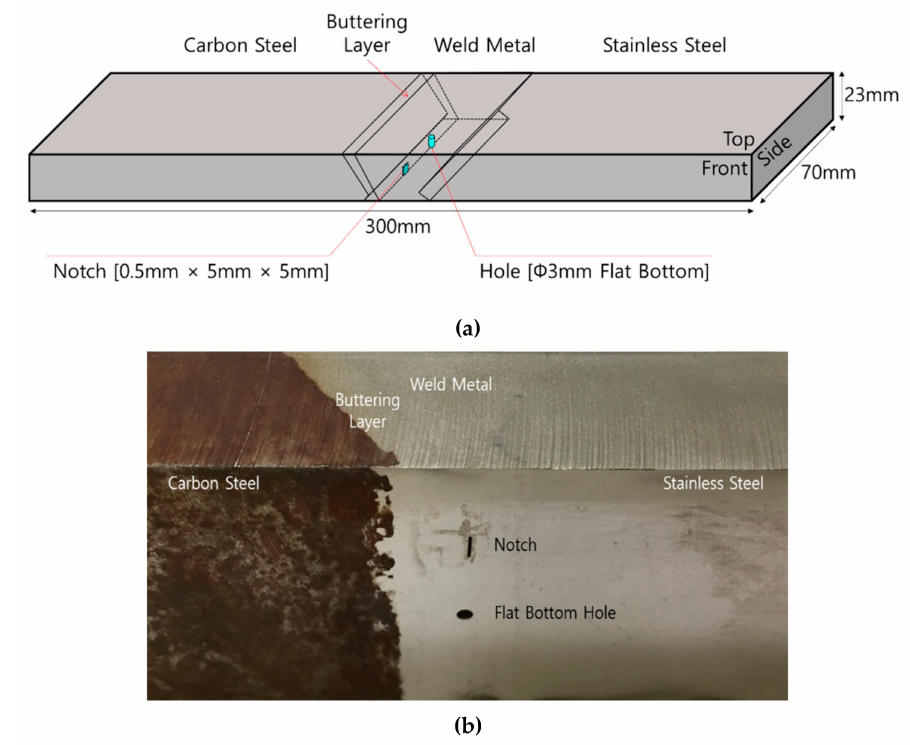
Figure 15. ( a ) Schematic illustration and ( b ) photograph of a DMW specimen with artificial cracks.